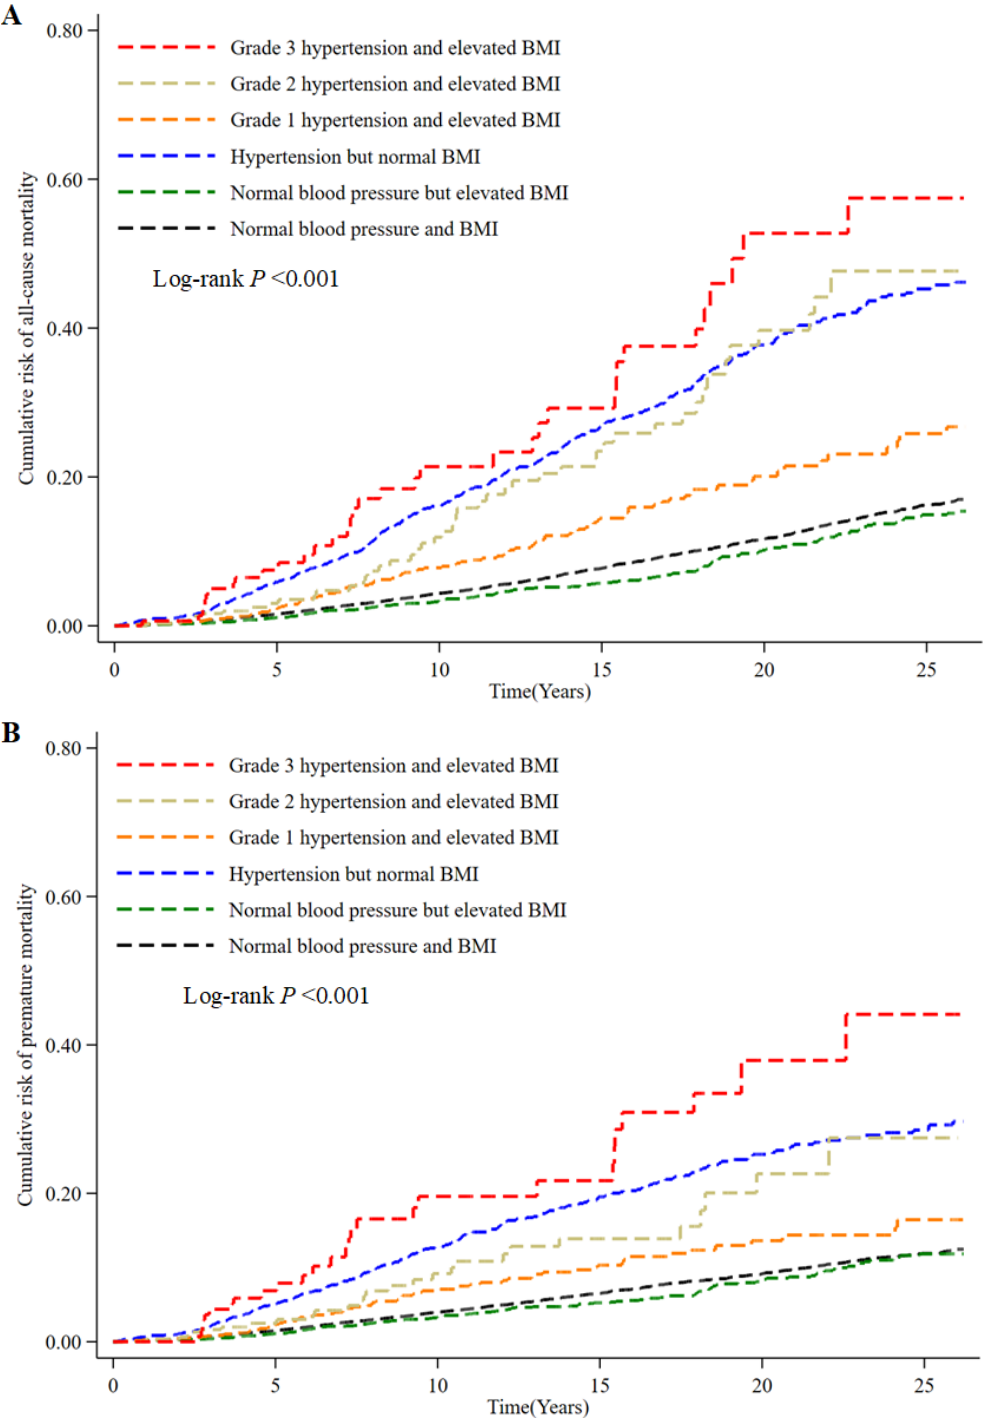
Figure 2. ( A ) Cumulative incidence of all-cause mortality according to hypertension and elevated BMI combination categories. ( B ) Cumulative incidence of premature mortality according to hyper- tension and elevated BMI combination